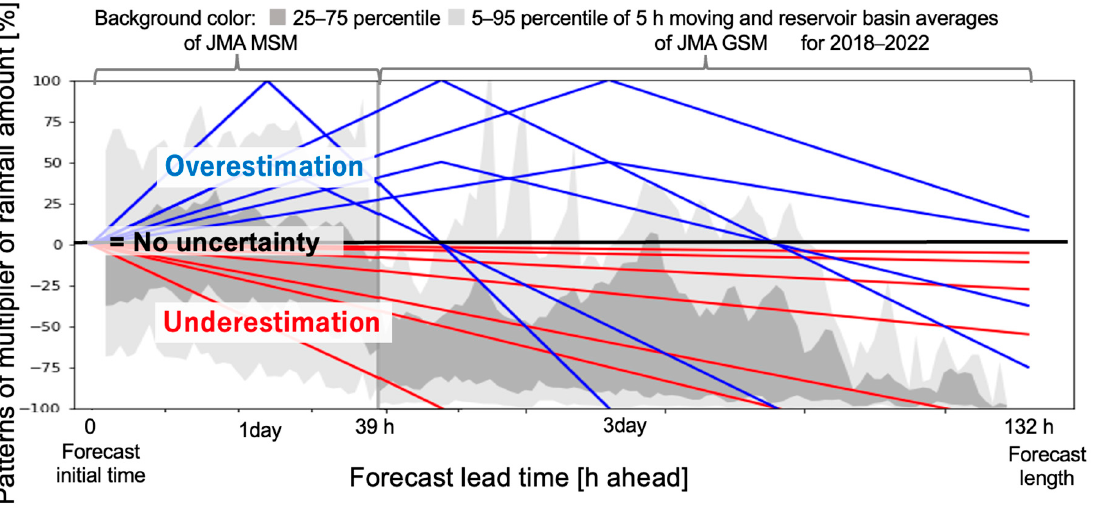
Figure 9. Forecast patterns with underestimation (red lines) and overestimation (blue lines) of rainfall amount linearly according to forecast-lead time. 5 h moving and reservoir basin averages of the JMA rainfall forecast for 2018–2022 (MSM –39 h ahead/GSM 40 h ahead–) is represented in background color: gray for 25–75 percentile and light gray for 5–95 percentile.